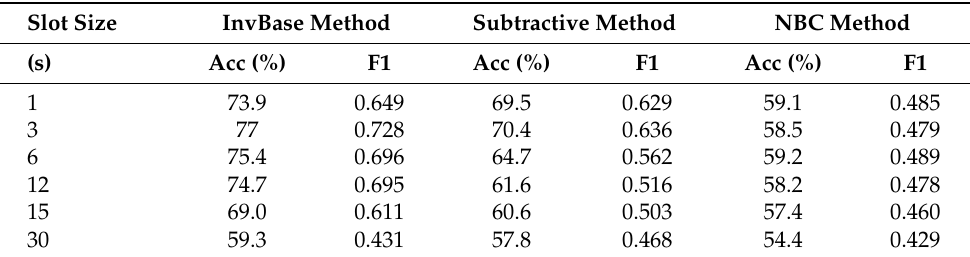
Table 7. Valence classification accuracies and F1 scores of InvBase, subtractive, and NBC methods using kNN with various slot sizes.